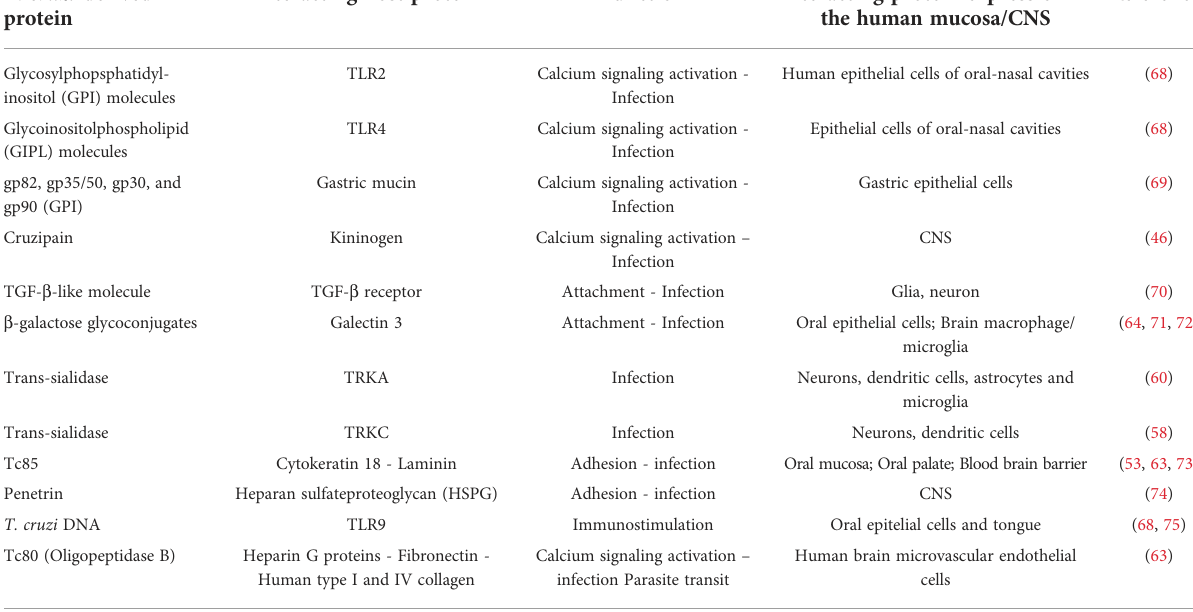
TABLE 2 Molecular interactions between T. cruzi and host molecules. T. cruzi